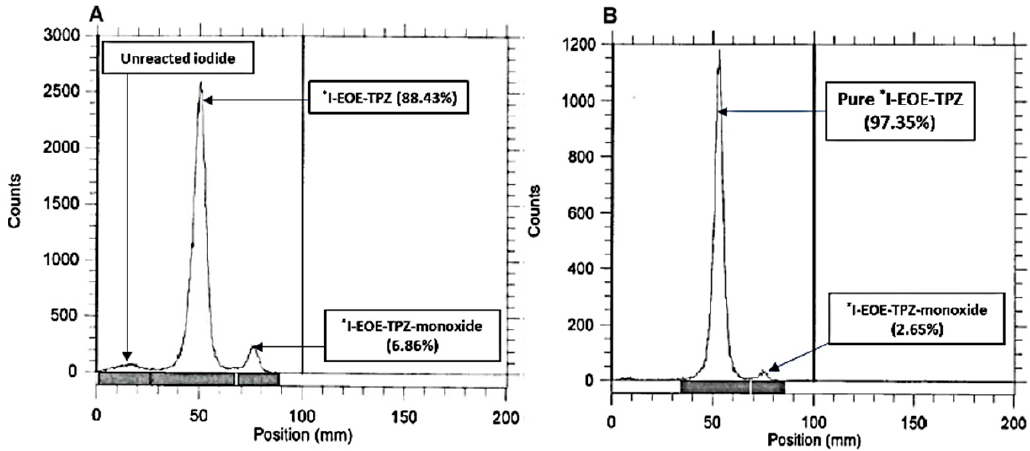
Figure 6. ( A ) The RTLC of the exchange-labeled [ 131 I]I-EOE-TPZ ( P2 ) reaction mixture in ACN, 30 min after reacting at 80 °C with sodium [ 131 I]iodide. ( B ) The RTLC of ( A ) after purification through a neutral alumina cartridge.